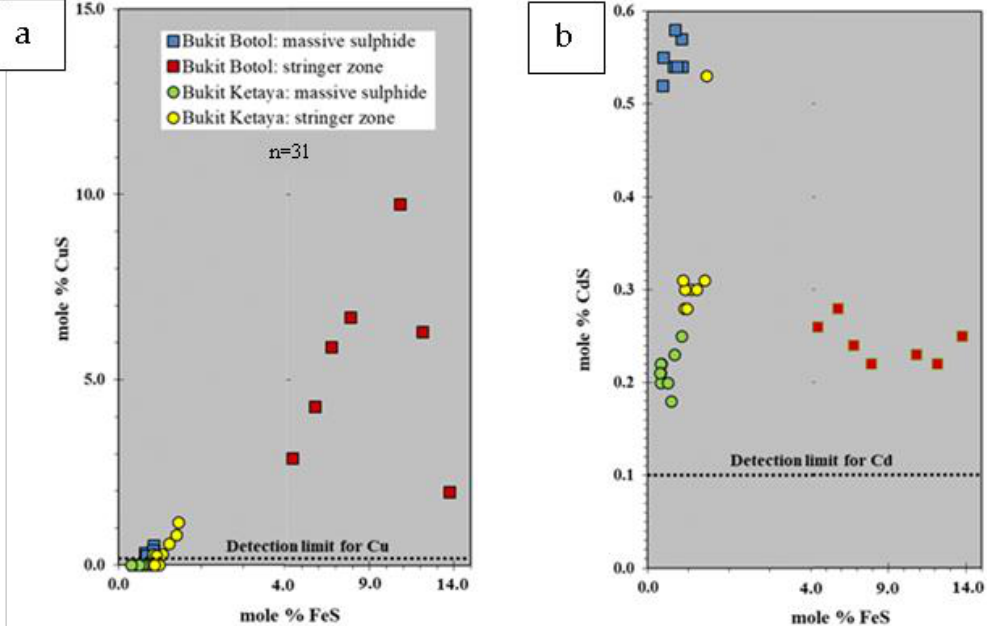
Figure 5. Plot showing mole% FeS, CuS and CdS variations in sphalerite from the Bukit Botol and Bukit Ketaya deposits, Central Peninsular Malaysia. ( a ) The relations between mole% CuS and mole% FeS. ( b ) The relationships between mole% CdS and mole% FeS.